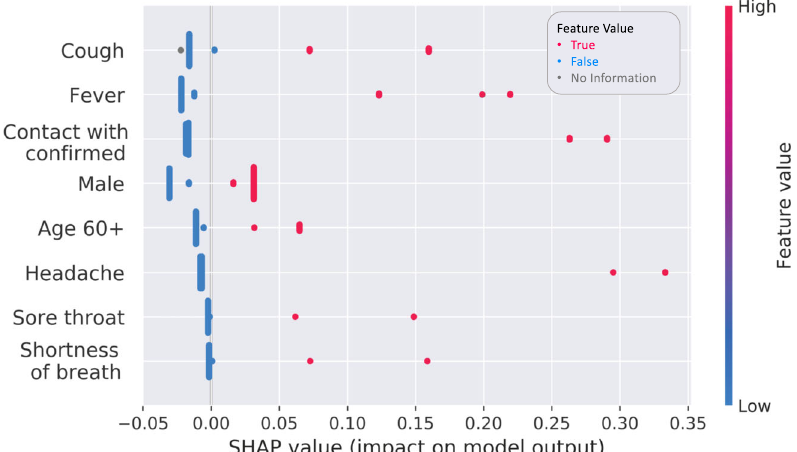
Fig. 2 Important features. SHapley Additive exPlanations (SHAP) beeswarm plot for predicting COVID-19 diagnosis, showing SHAP values for the most important features of the model. Features in the summary plots ( y -axis) are organized by their mean absolute SHAP values. Each point corresponds to an individual person in the study. The position of each point on the x-axis shows the impact that feature has on the classi fi er ’ s prediction for a given individual. Values of those features (i.e., fever) are represented by their